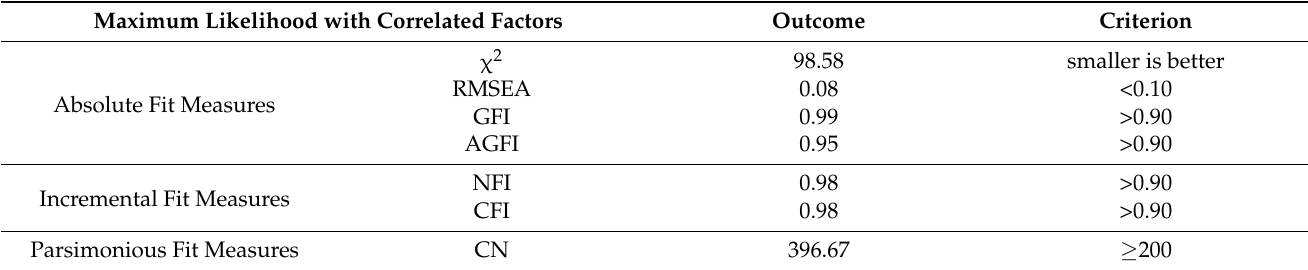
Table 3. Fit indices for the performance model of the LSI-SF.